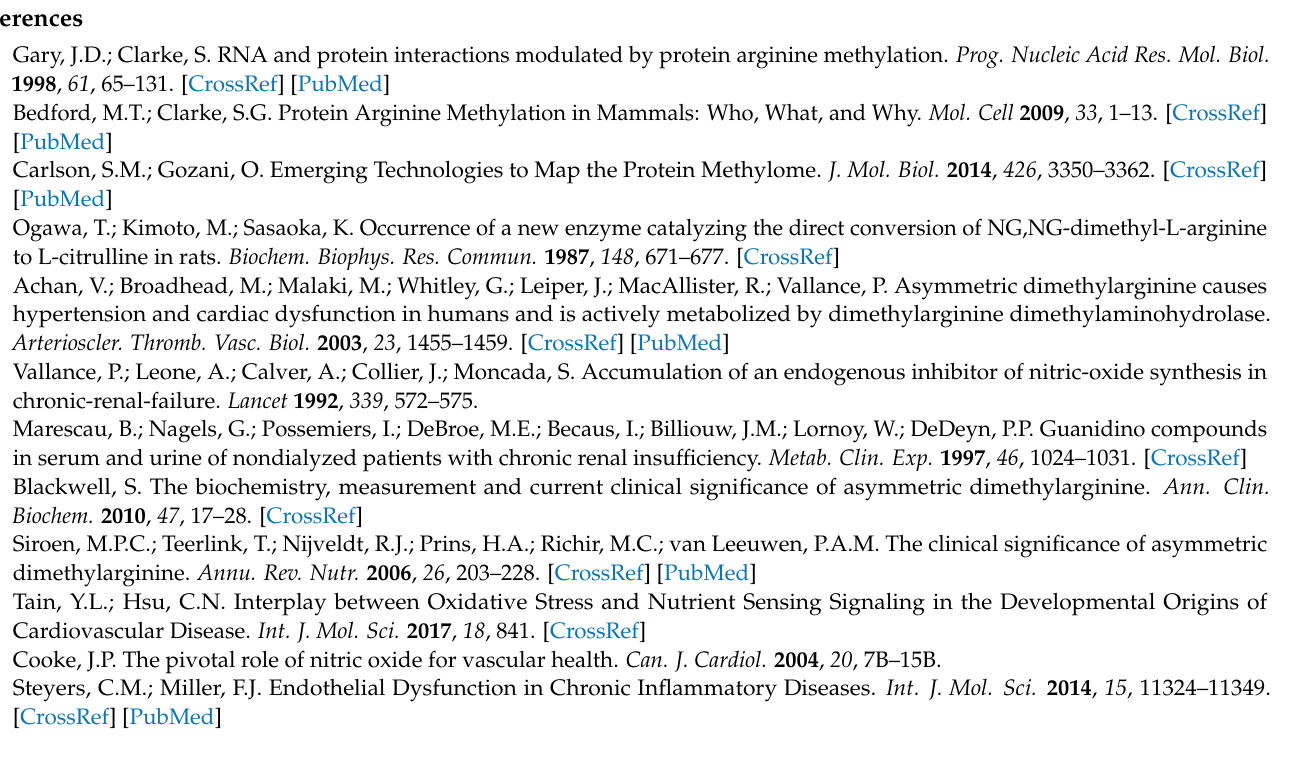
Figure A1. Electrophoretic stacking of the model sample (0.1 µM MMA, ADMA and SDMA in an ACN/infusion solution of 3:1) with filling 100% of the capillary with the sample ( A ), and after a short BGE zone is introduced into the exit end of the capillary with 94.5% sample filling ( B ). Peak identification: 1—MMA; 2—ADMA; 3—SDMA.